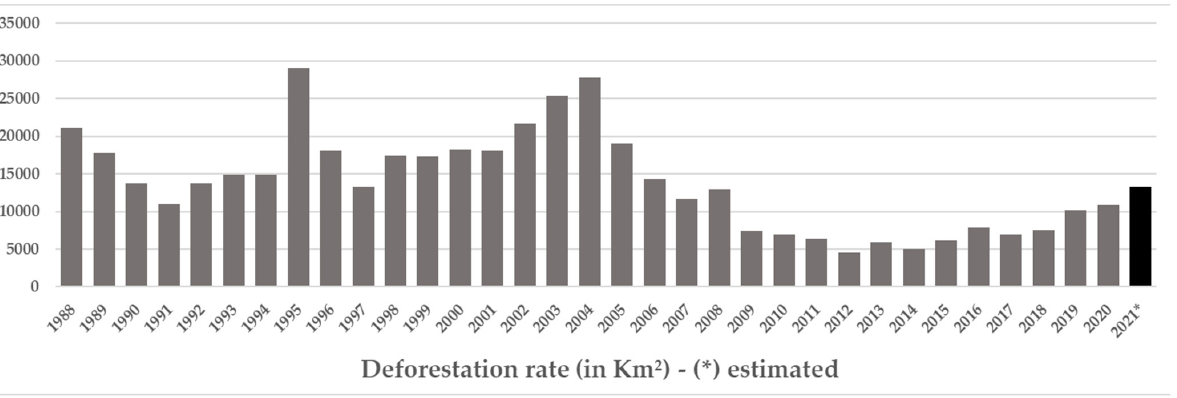
Figure 2. Annual rate of deforestation—estimates for 2021 in black. Source : Official estimates by the Instituto Nacional de Pesquisas Espaciais (INPE) 9